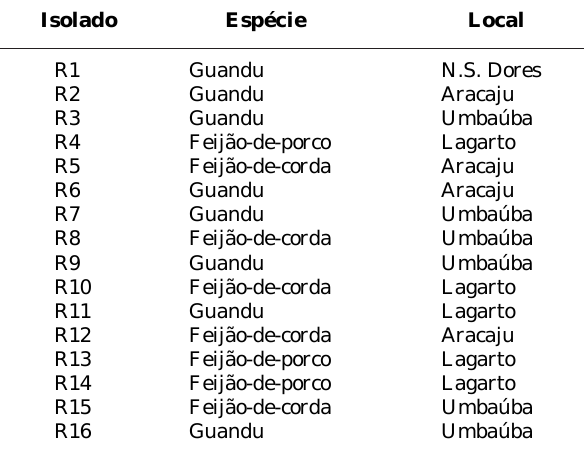
(1) Os isolados de mesma espécie e mesmo local foram obtidos de nódulos provenientes de plantas distintas, localizadas a, pelo menos, 50 m entre